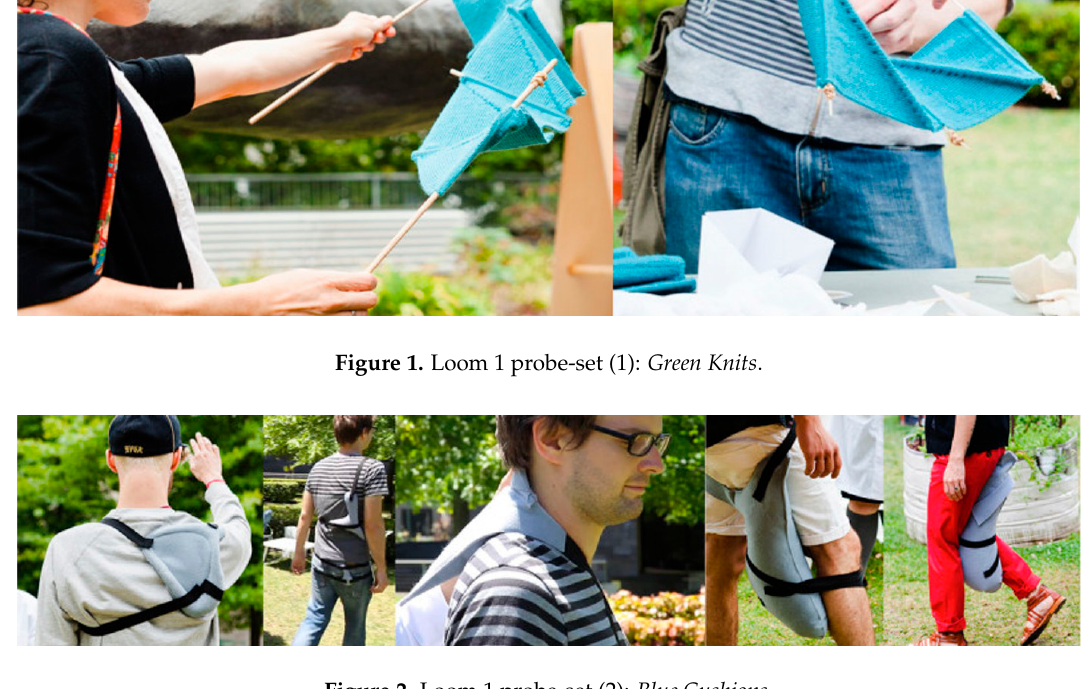
Figure 2. Loom 1 probe-set (2): Blue Cushions.